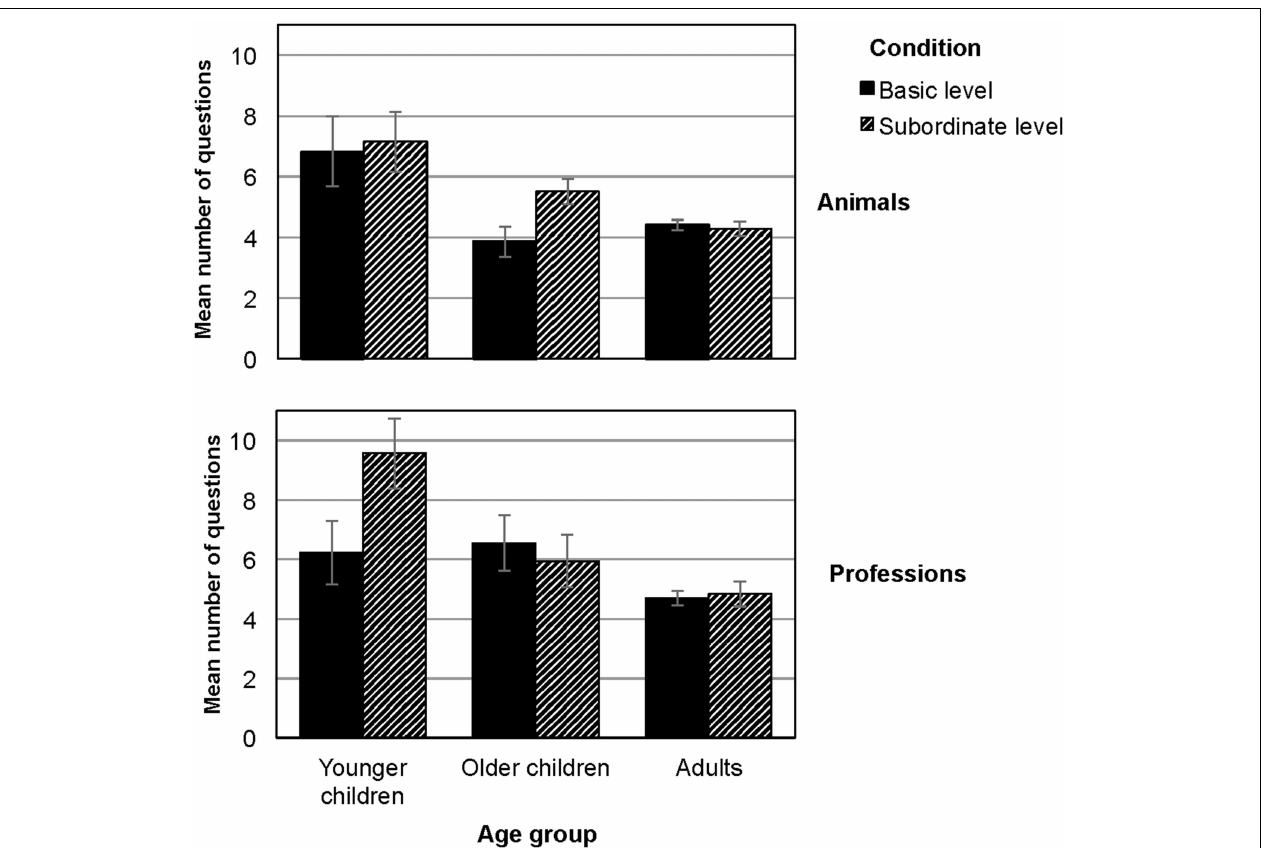
FIGURE 1 | Number of questions needed to reach the solution, displayed by domain (animals, professions) and condition (basic level, subordinate level). Error bars indicate one SEM in each direction.